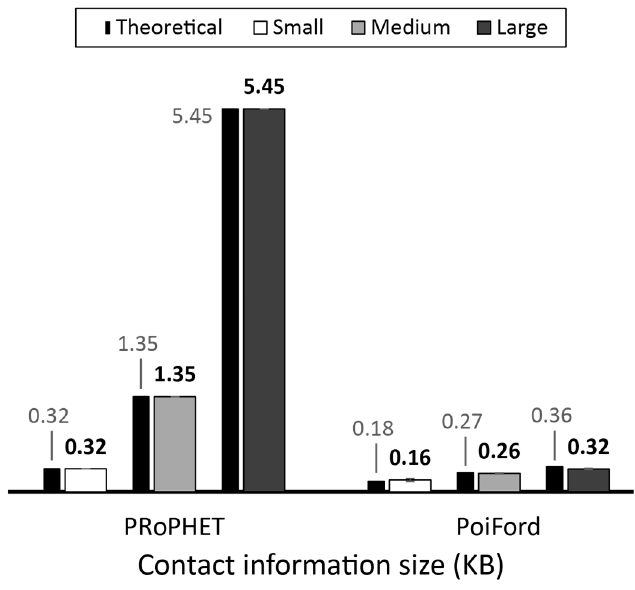
Figure 8. Theoretical and simulated average contact information size on nodes running on PRoPHET and PoiFord over the small, medium and large scenario.